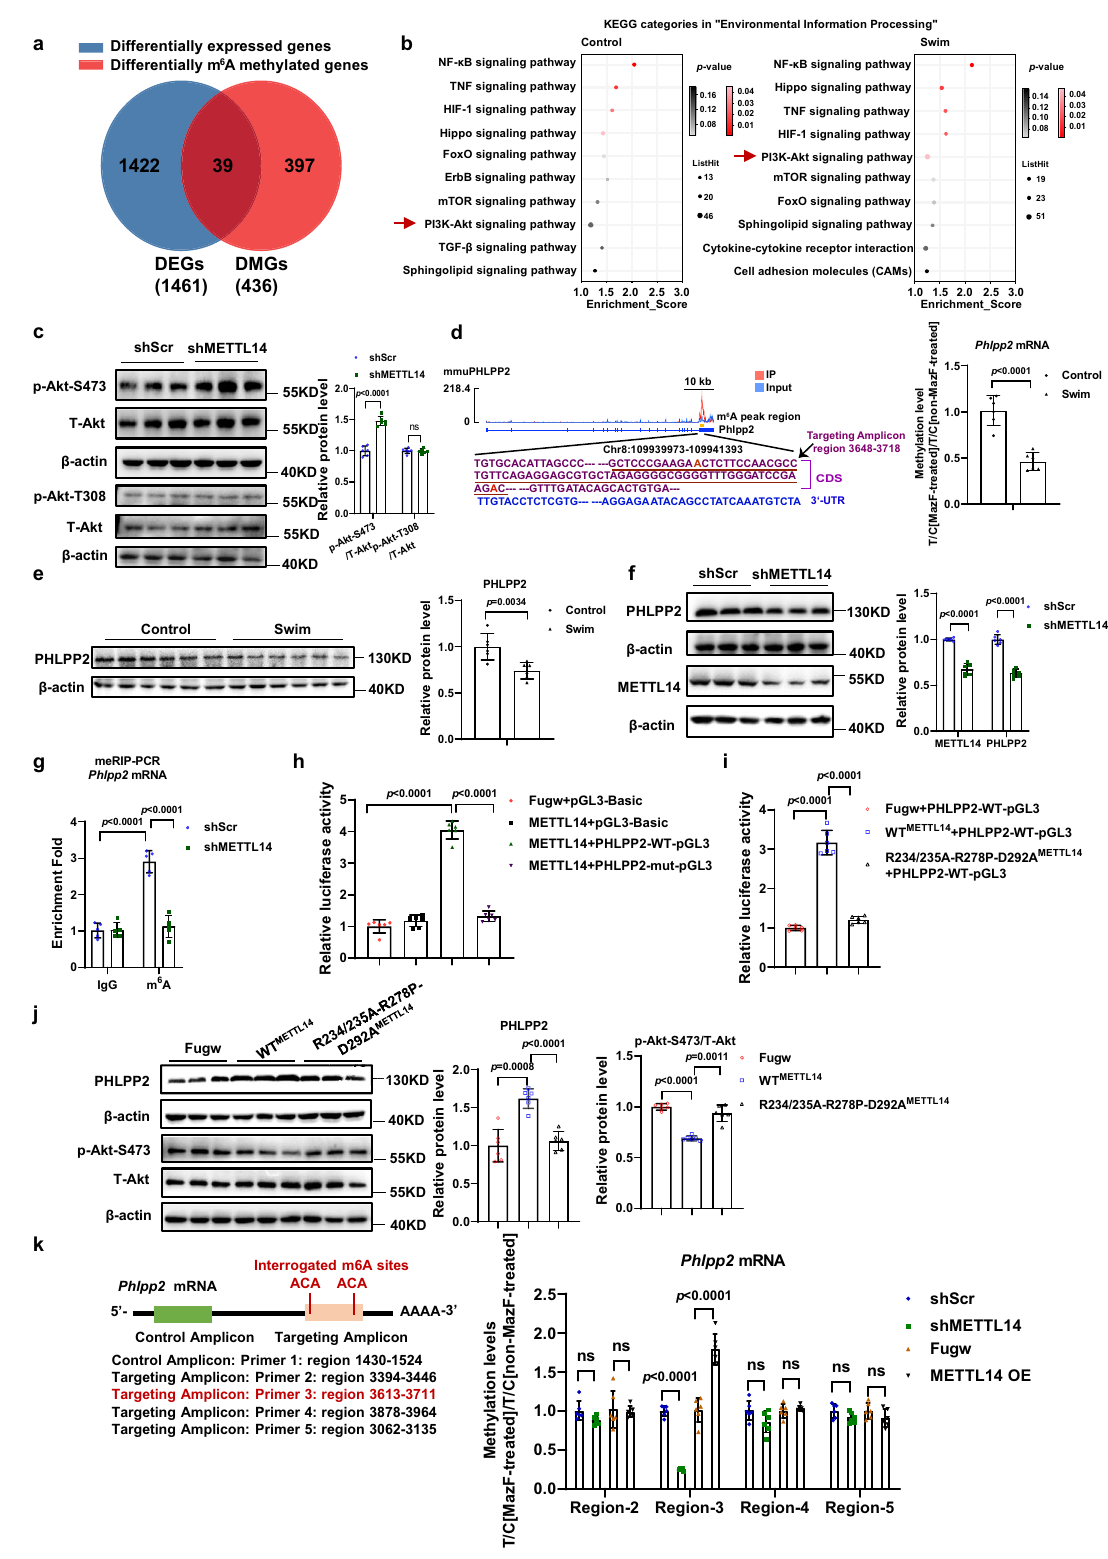
usedasinternalcontrols.Primersequencesusedinthisstudyarelisted in Supplementary Table